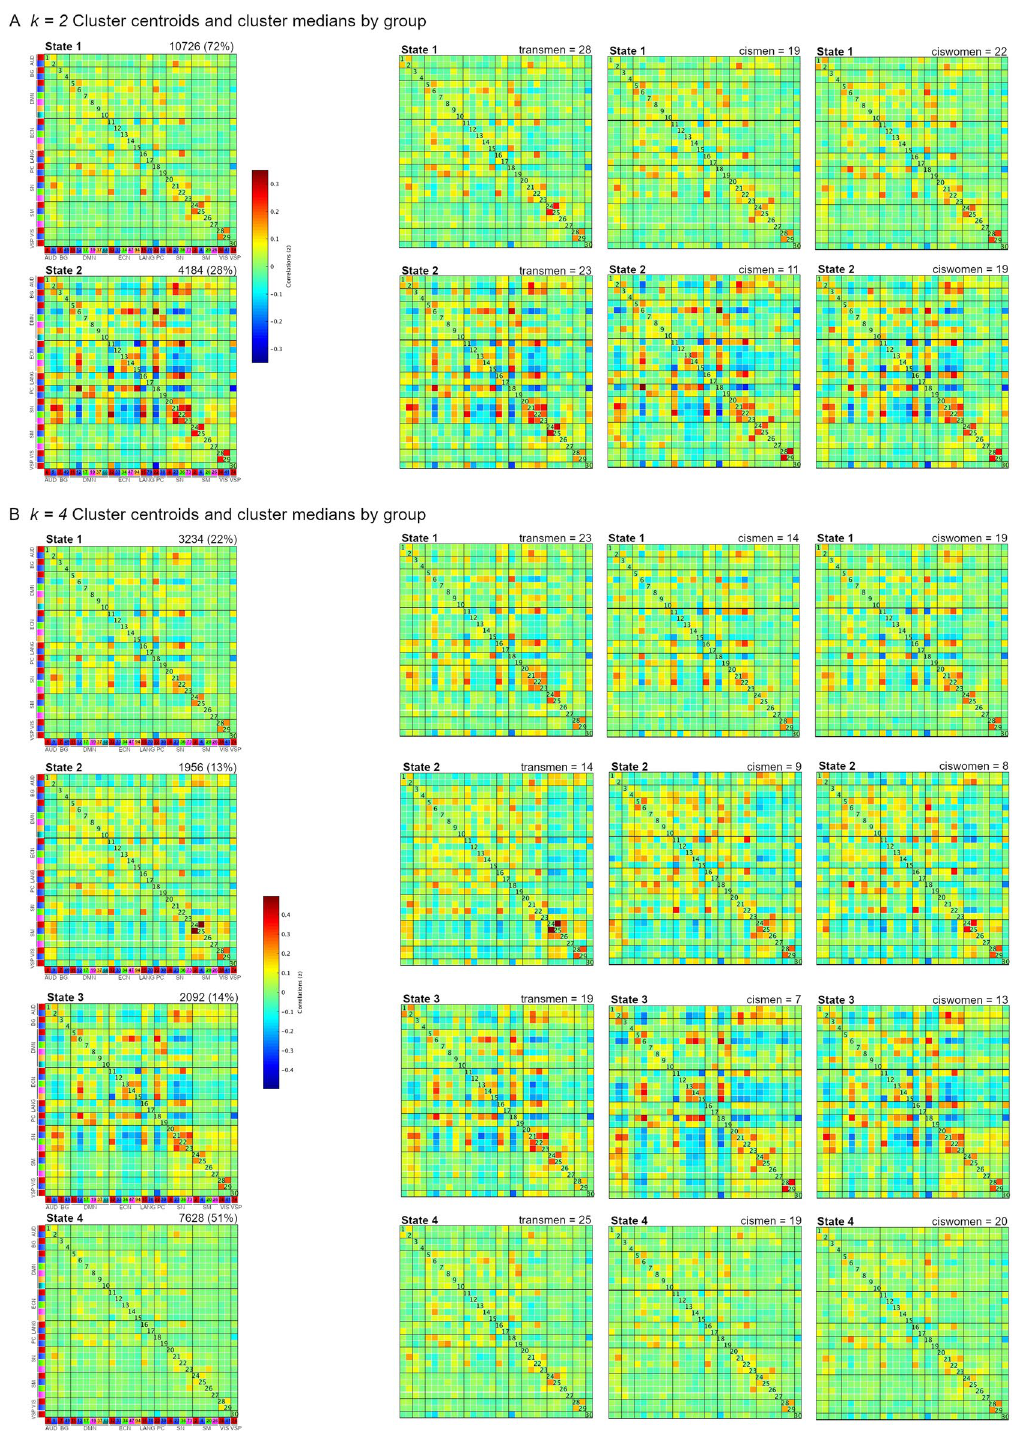
Figure 3. Cluster centroids of the whole sample and group-specific cluster medians. ( A ) Results from the 2-clusters solution ( k = 2 ). ( B ) Results from the 4-clusters solution ( k = 4 ). Matrices were obtained from the GIFT toolbox 22